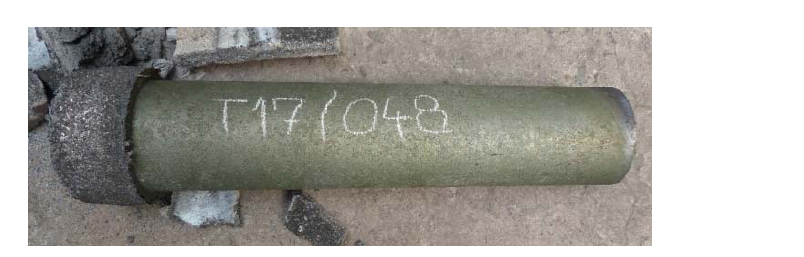
Figure 1. MoNiCr ingot. Table 1. HN80MTY.